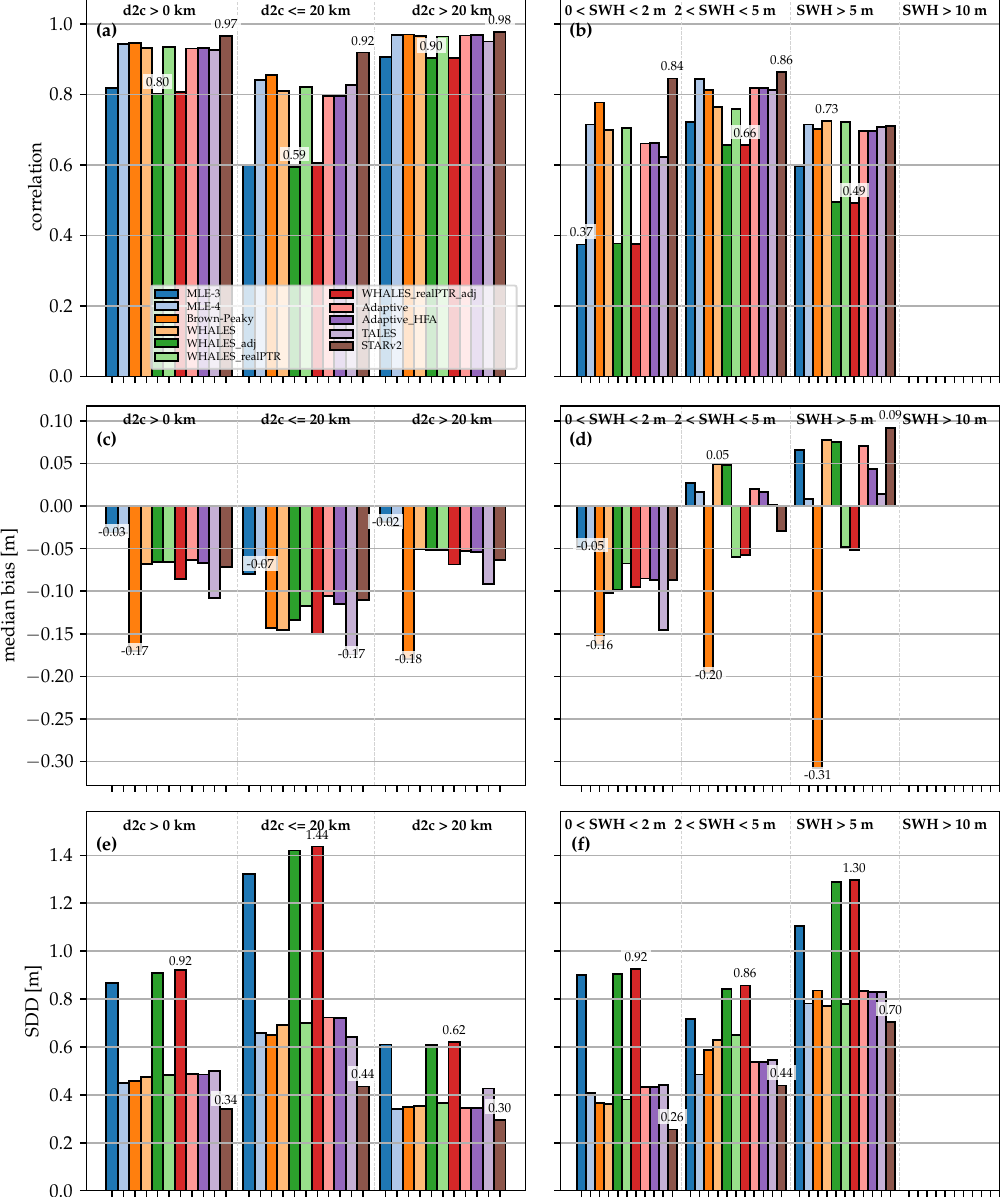
Figure 11. Comparison of the ( a/b ) correlation coefficient, ( c/d ) median bias, ( e/f ) SDD against in-situ buoy data of the individual J3 retrackers as a function of dist2coast and of SWH, respectively. Overall, the median bias values are much smaller than SDD values shown in the plots in the bottom row of Figure 11. For the open-ocean and coastal zone, the SDD metric behaves similar to the correlation coefficient. The best results are achieved by STARv2 retracker and the worst performance is demonstrated by MLE-3, WHALES-adj and WHALES_realPTR_adj. These three algorithms show the worst results for the average sea state conditions and their performance is also poor for the low and high sea states. STARv2 has the lowest values in all three regimes and gives its best